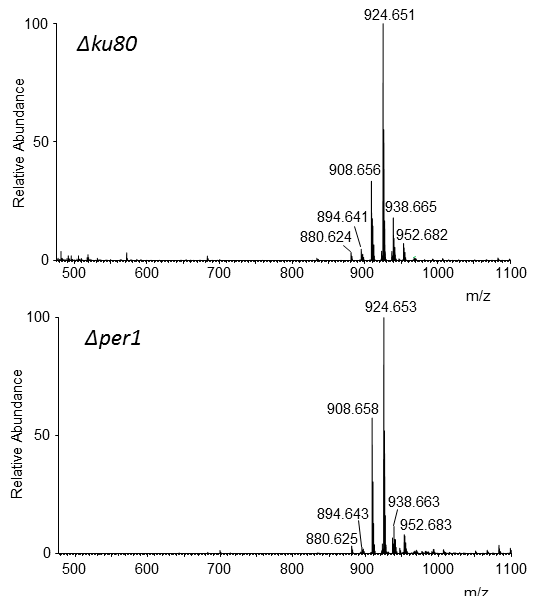
Figure 8. MS data of lipid moieties of the purified lipogalactomannan LGM from parental ( Δ ku80 ) and Δ per1 mutant strains. (Major ions: m / z 924.651, inositolphosphoceramide (IPC) composed of a C 18 -phytosphingosine and 2-OH-C 24:0 ; m / z 908.656, IPC composed of C 18 -phytosphingosine and C 24:0 ).